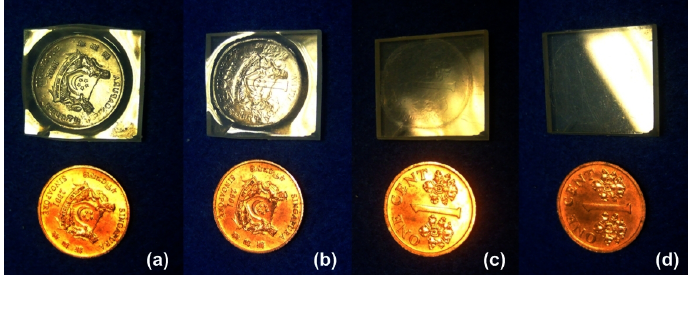
Figure 32. Demonstration of the step-by-step recovery in PS. ( a ) After programming; ( b ) after heating to about 80 °C; ( c ) after heating by boiling water; and ( d ) after further heating using a